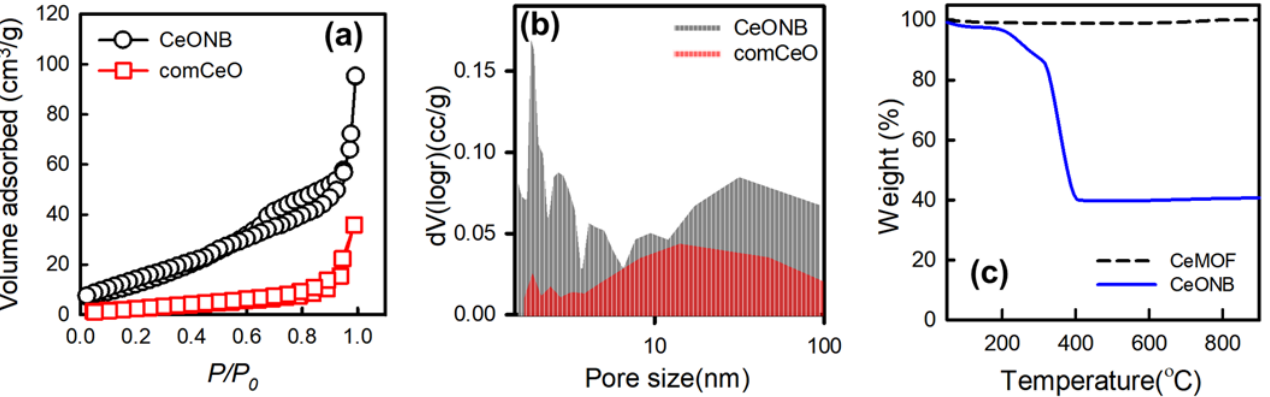
Figure 5. ( a ) N 2 sorption isotherms, and ( b ) pore size distributions of CeONB and comCeO; ( c ) TGA analyses of CeMOF, and CeONB.